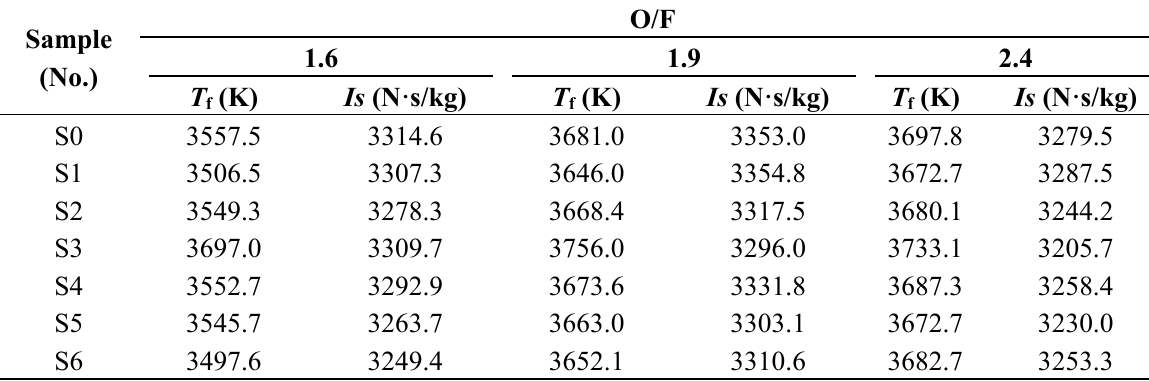
Table 2. Fuel energy characteristics under different